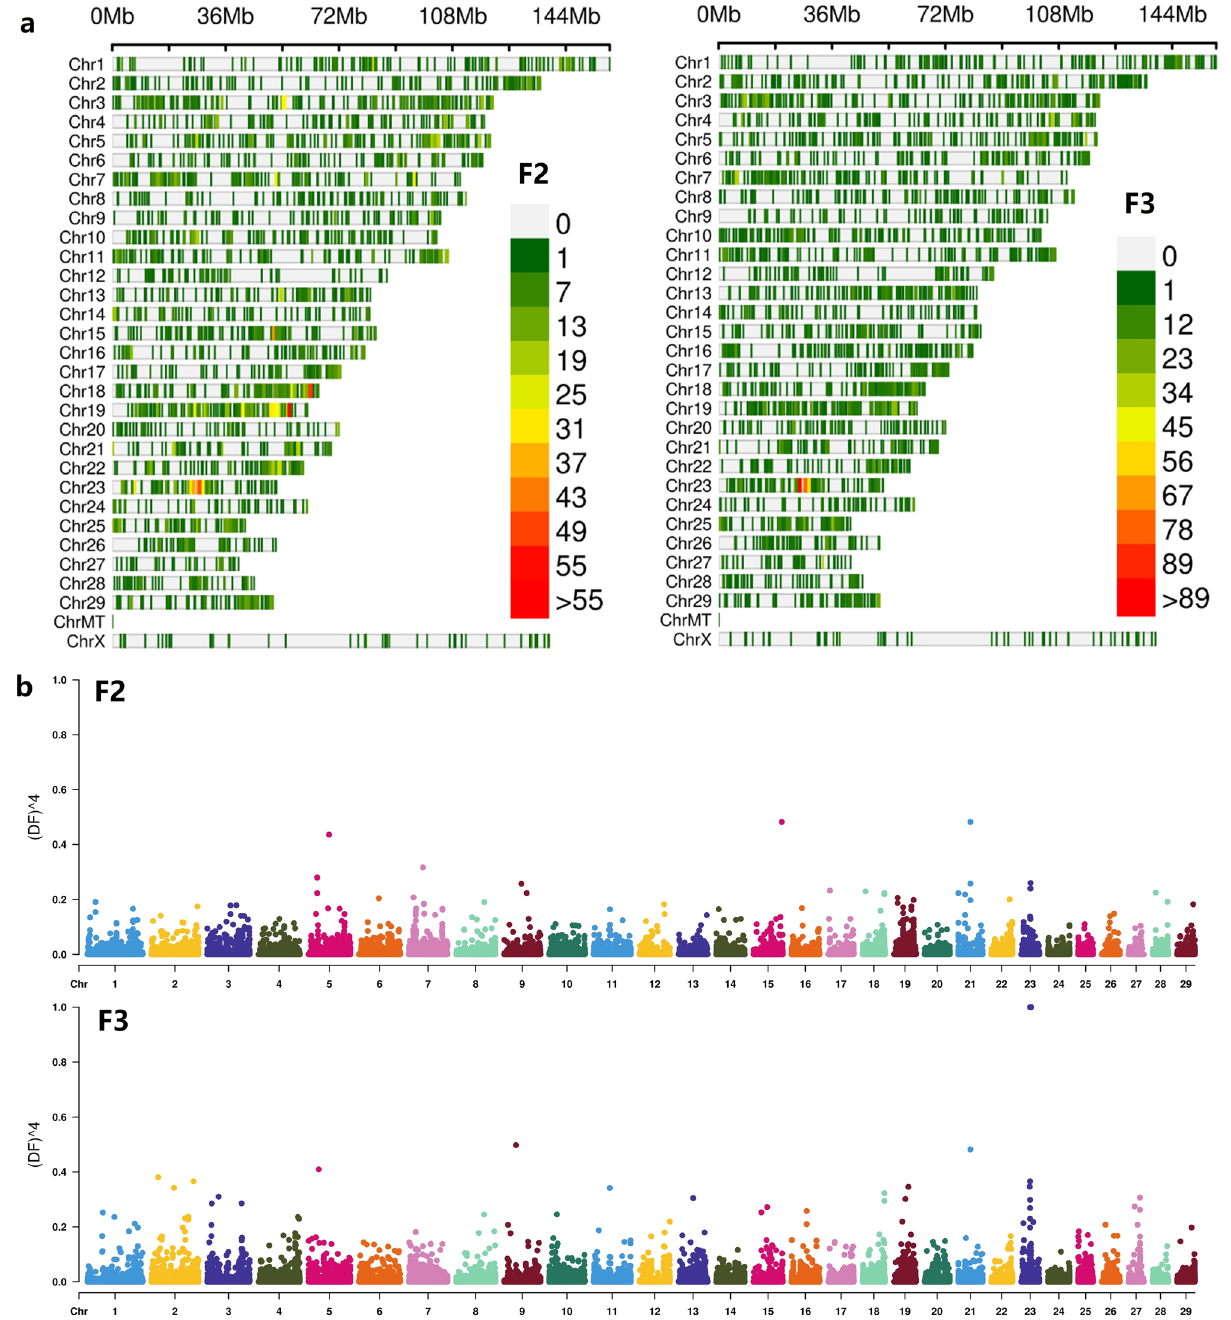
Figure 3. ( a ) SNP density plot (Filter SNP with allelic frequency difference > = 0.3 in two groups). Figures from left to right were the population F2 and F3; ( b ) QTL-mapping of allele frequency difference of F2, and F3 population with the degree of